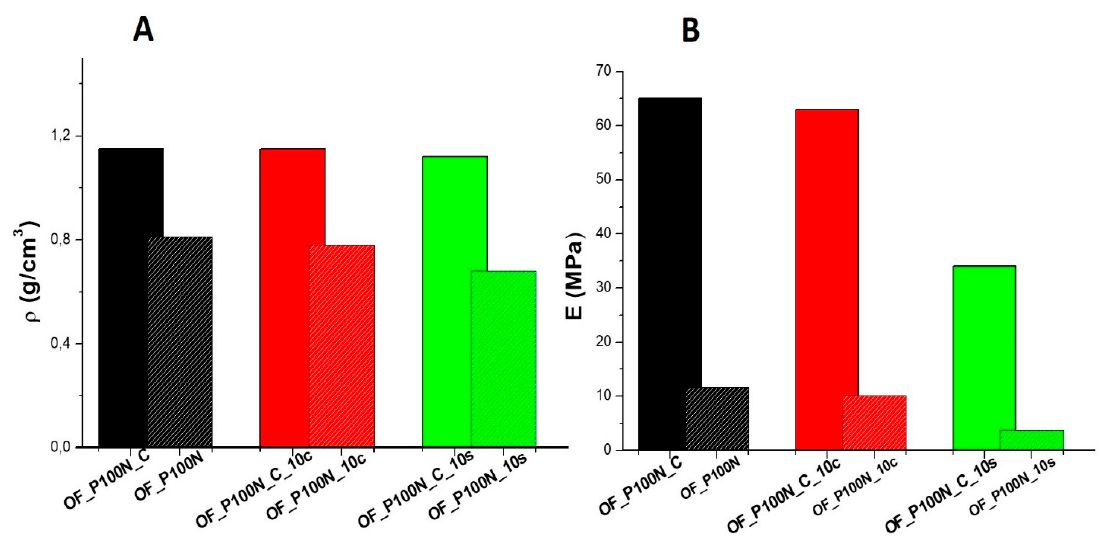
Figure 5. Density ( A ) and compressive modulus ( B ) of the catalyzed and uncatalysed UF/OFMSW Figure 5. Density( A )andcompressivemodulus( B )ofthecatalyzedanduncatalysedUF / blends.